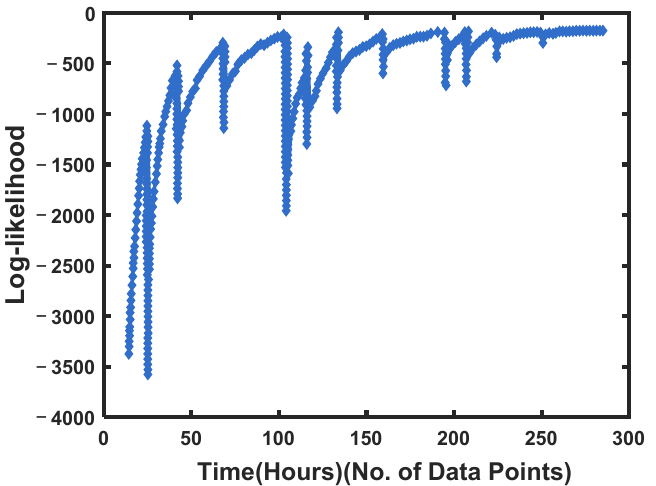
Figure 5. Log-likelihood convergence trend with an increasing number of data samples correspond- ing to the number of iterations. The trend converges and saturates towards a global optimum.